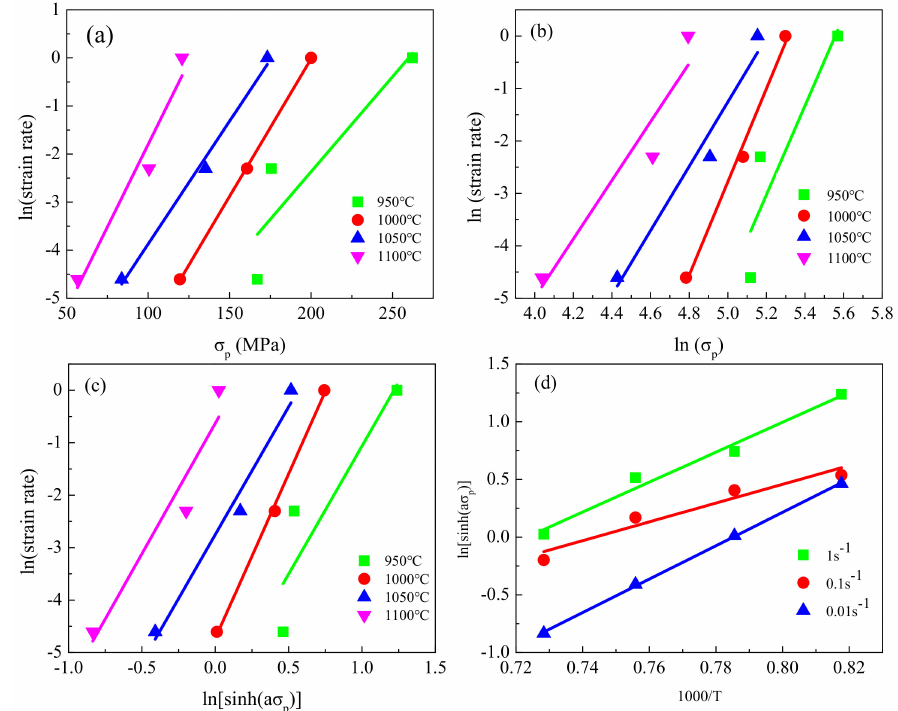
. ε . ε . ε and σ p ; ( b ) ln and ln σ p ; ( c ) ln and lnsinh( ασ p ); ( d ) lnsinh